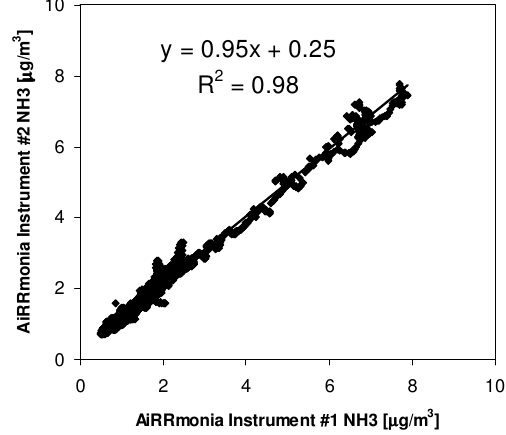
Fig. 2. Intercomparison between the two AiRRmonia instruments deployed during the measurement campaign. Site used for the inter- comparison: UB. Temporal resolution: 1